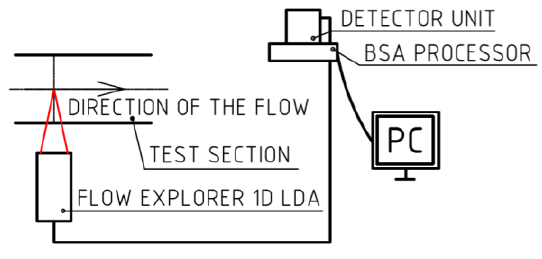
Fig. 4. LDA experimental setup .